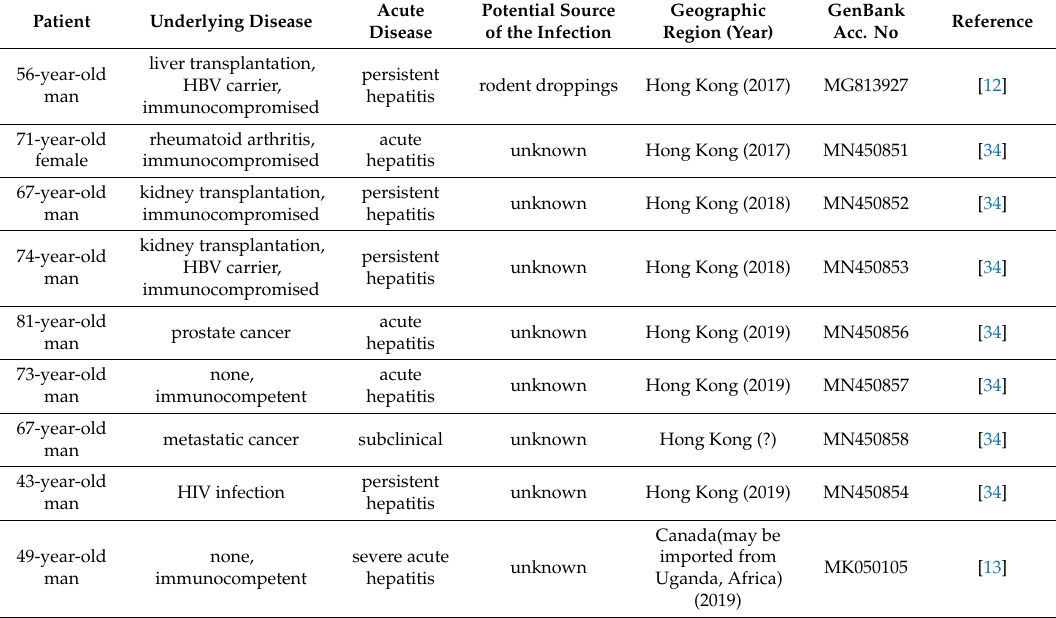
Table 3. Summary of human infections ( N = 9) associated with rat origin HEV-C1 virus (species Orthohepevirus C ) in the literature. HBV = hepatitis B